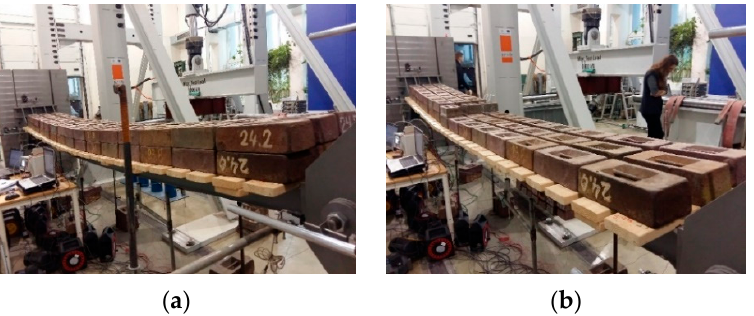
Figure 4. Typical loading layouts: ( a ) symmetrical load situation; ( b ) asymmetrical load situation.